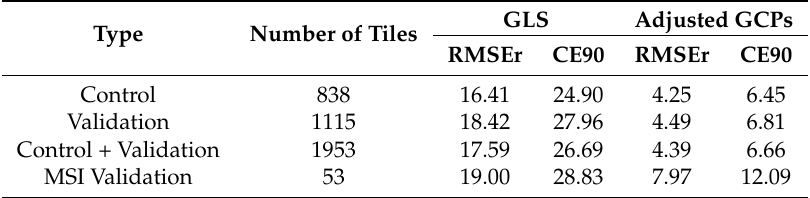
Table 12. Validation results for the Eurasia block using Image-to-Image characterization between the Sentinel-2 GRI tiles and Landsat 8 L1T products that were processed before (GLS) and after (Adjusted GCPs) bundle